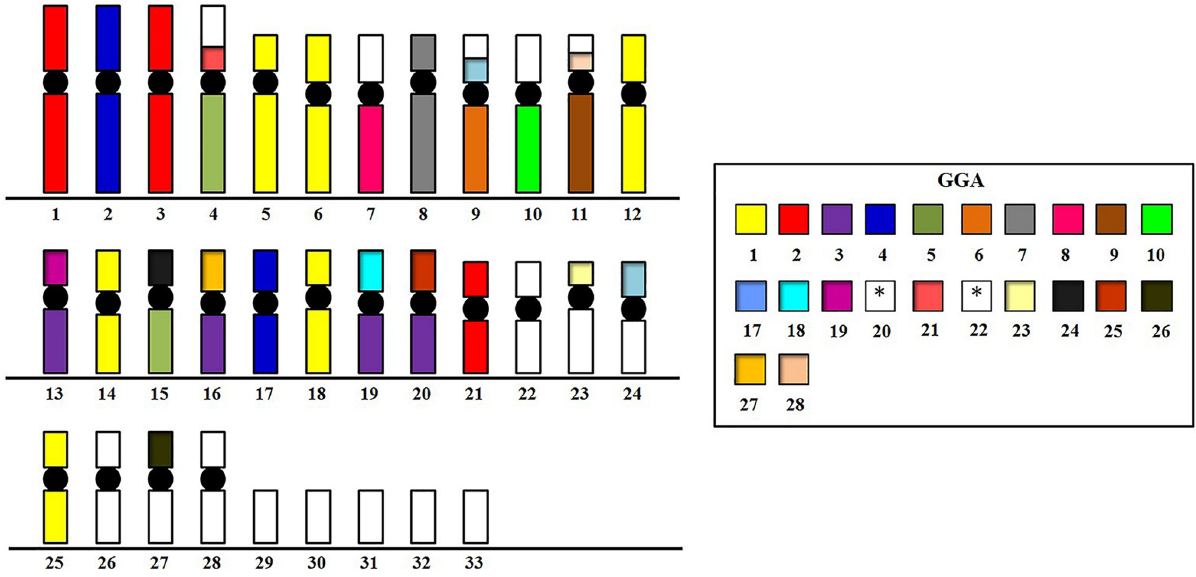
Fig 4. Idiogram representing the homology between the S . tyrannus chromosomes and the macrochromosome chromosome-specific probes and microchromosomes BAC clones from G . gallus . Empty boxes mean no signal detected in those chromosomes with the set of probes used. BACs corresponding to pairs 20 and 22 ( � ) was not used or did not produce any detectable signals,